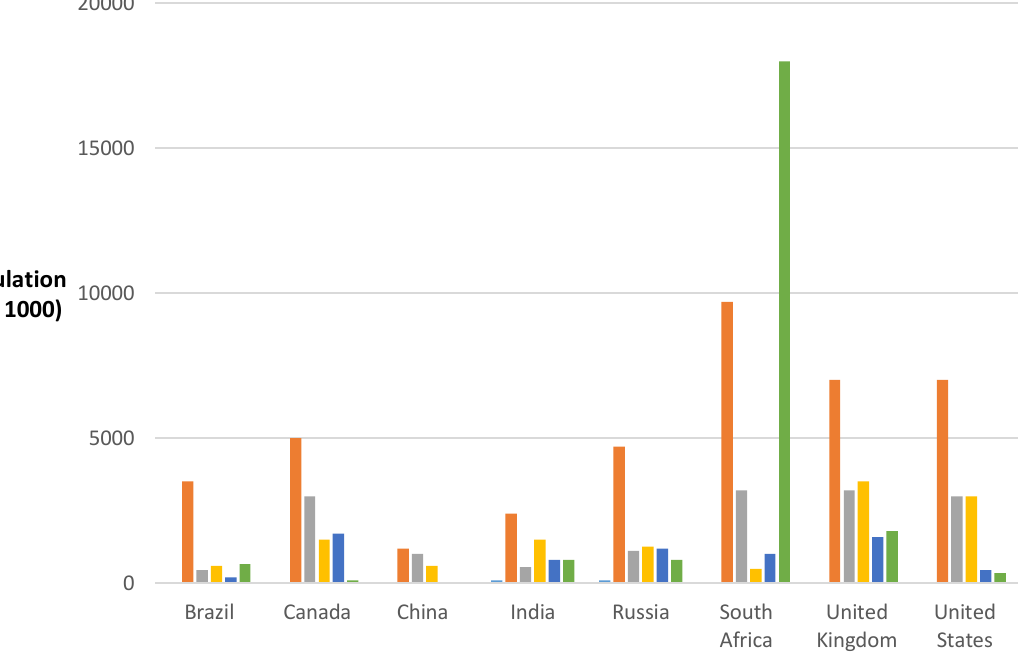
Figure 2: Percentage changes in antibiotics consumption per capita 2000 – 2010 by country. The blue colours indicate decreases while the rest are increases. Picture adapted from [4].